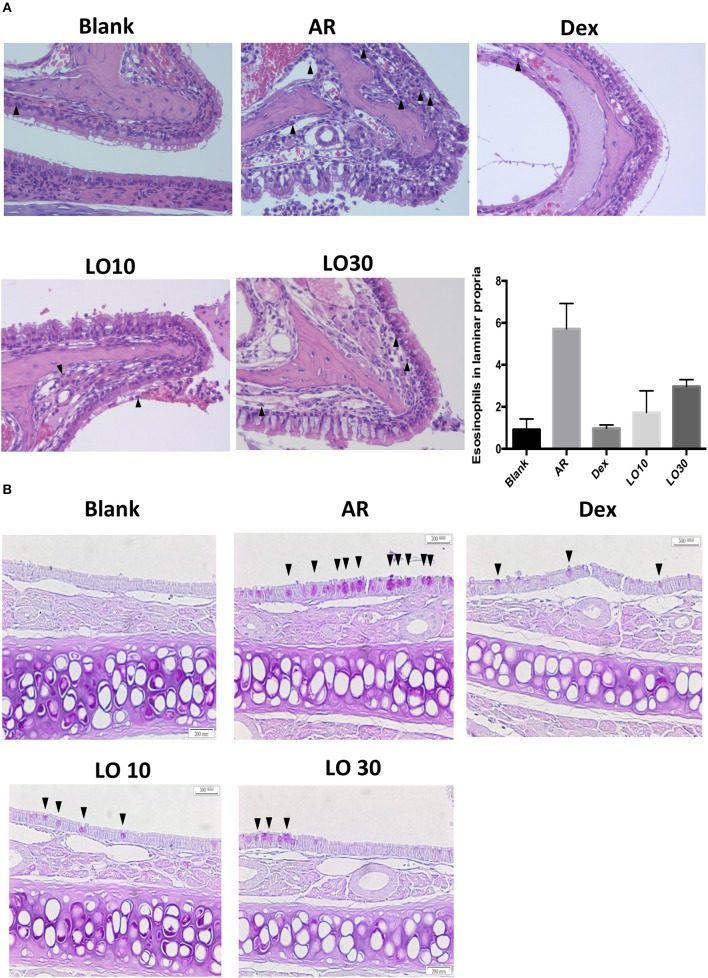
(A) Hematoxylin and eosin staining (400×) of tissue sections from experimental mice. The arrowheads mark the eosinophils in laminar propria. (B) Periodic acid-Schiff staining of the nasal mucosa from experimental mice (400×). The arrowheads mark the PAS staining cells.